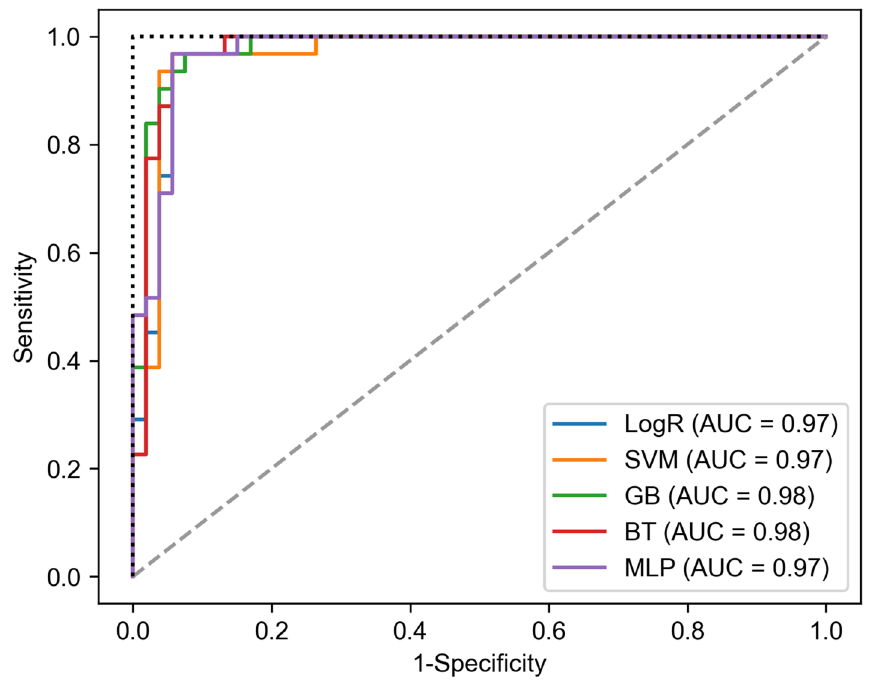
Figure 2. The receiver operating characteristic curve comparing five classification models in machine